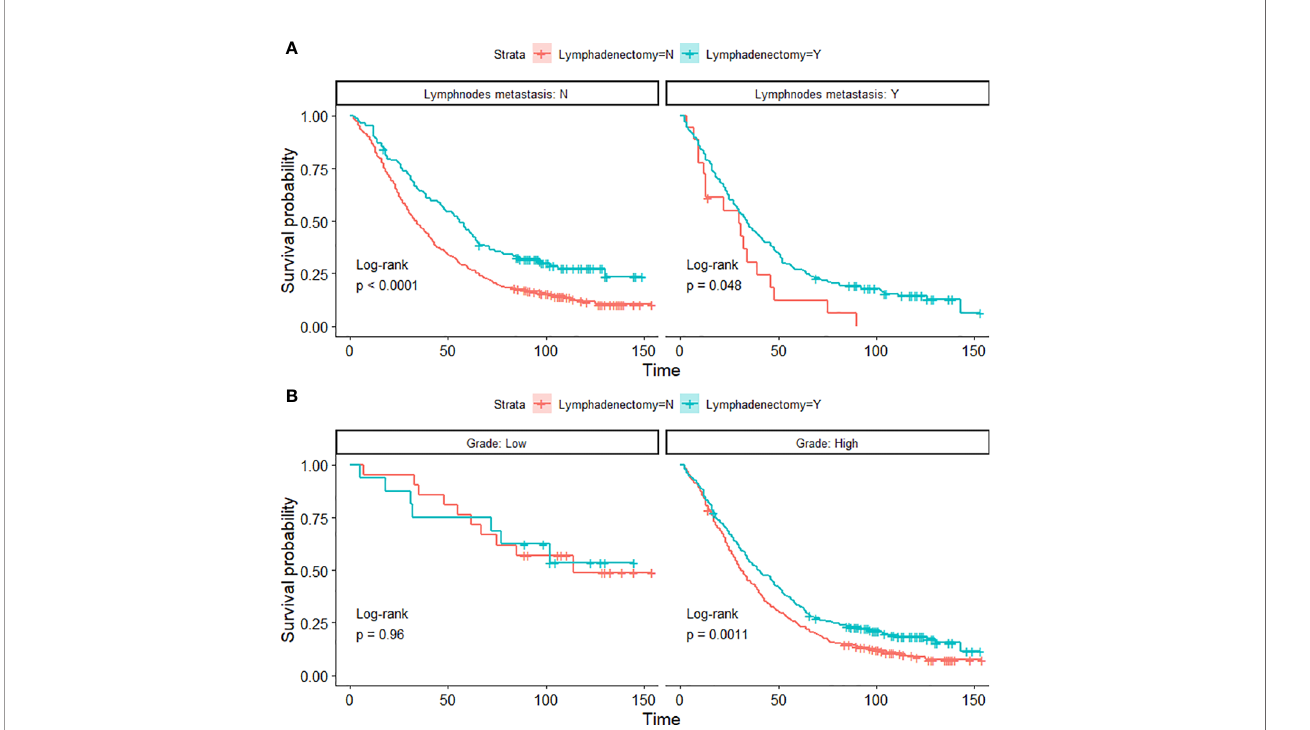
FIGURE 4 | Kaplan-Meier OS curves of lymphadenectomy in lymph node metastasis groups (A) and histological-grade groups (B) of PPSC patients in the developmental